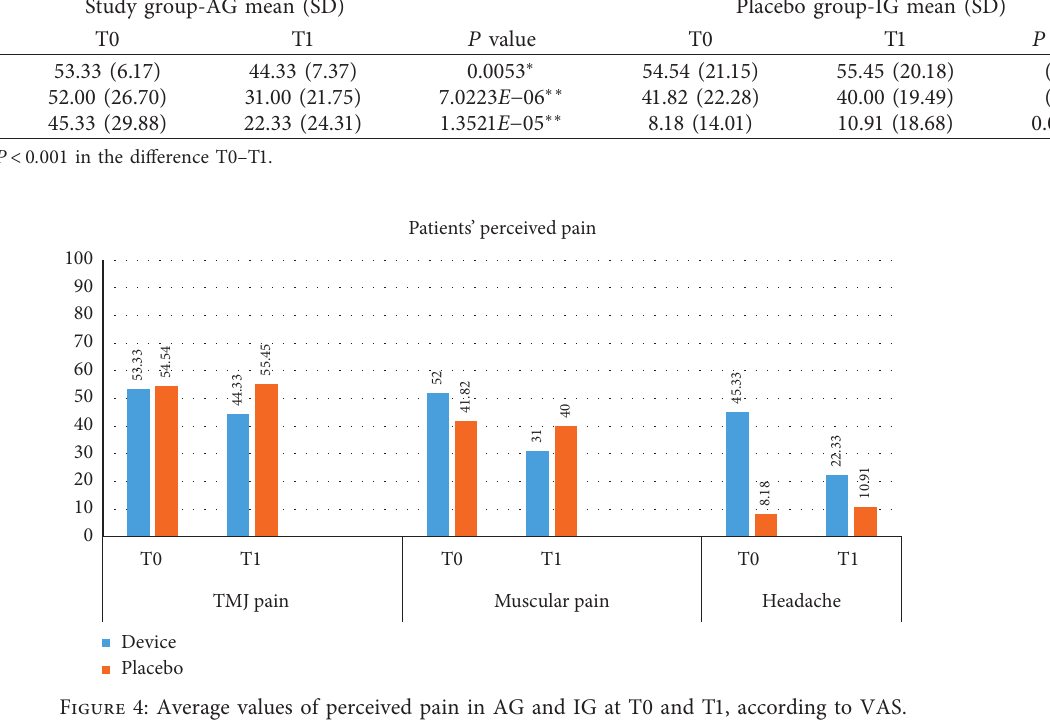
Table 2: Average values of perceived pain in AG and IG. Study group-AG mean